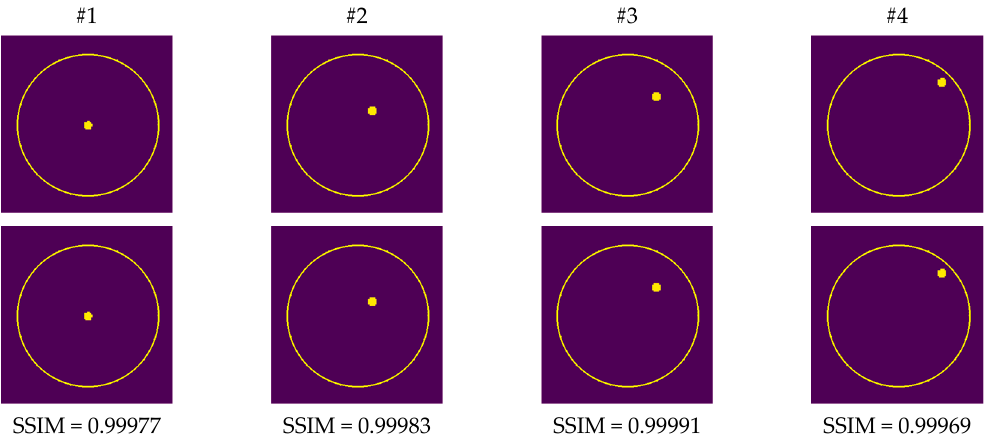
Figure 13. Comparison of samples of microwave images generated by the proposed CV-MWINet model for measurement data (metal screw in fine dust).